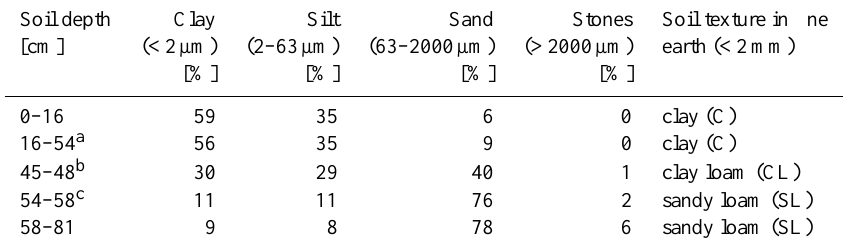
Table 2. Soil particle size distribution and soil texture of the local soil in the study area according to IUSS Working Group WRB (2014). Soil depth Clay Silt Sand Stones